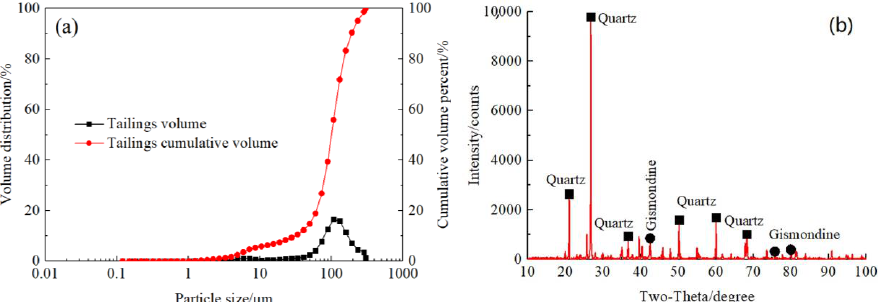
Figure 1. Fundamental characteristics of the studied tailings: ( a ) particle size distribution curve; ( b ) X-ray diffraction curve. Table 1. Chemical components of the studied tailings.